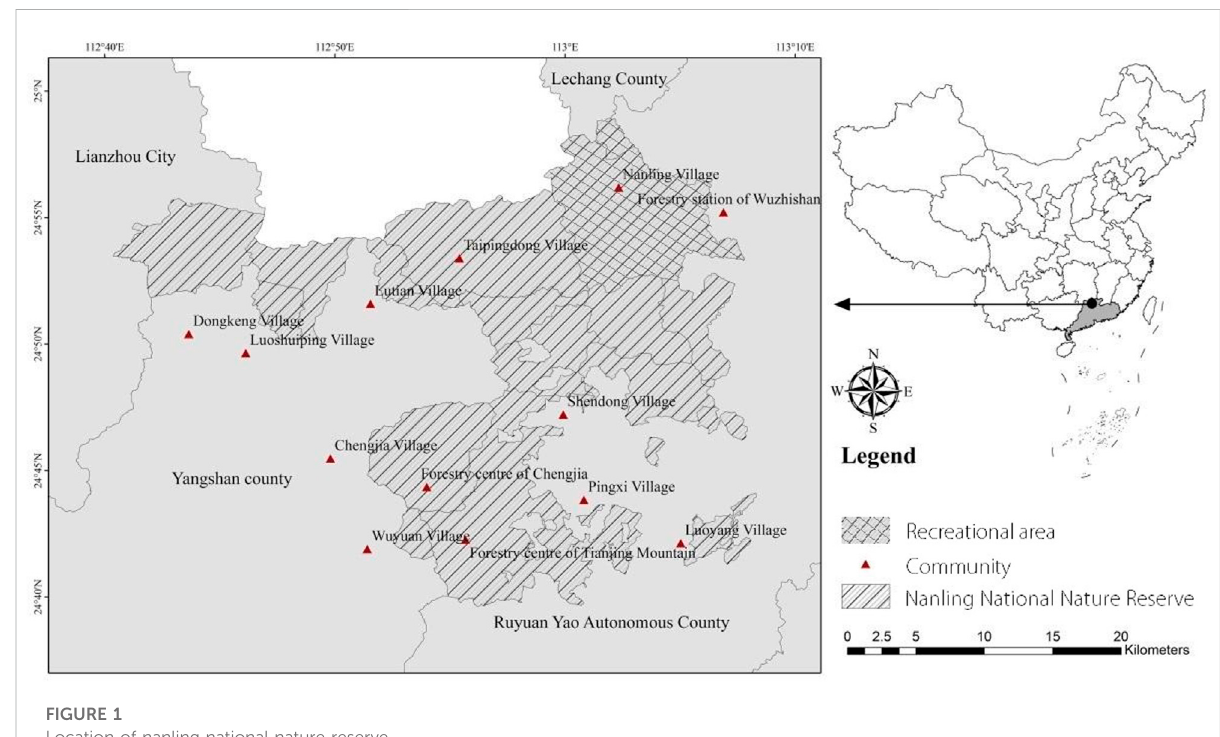
FIGURE 1 Location of nanling national nature